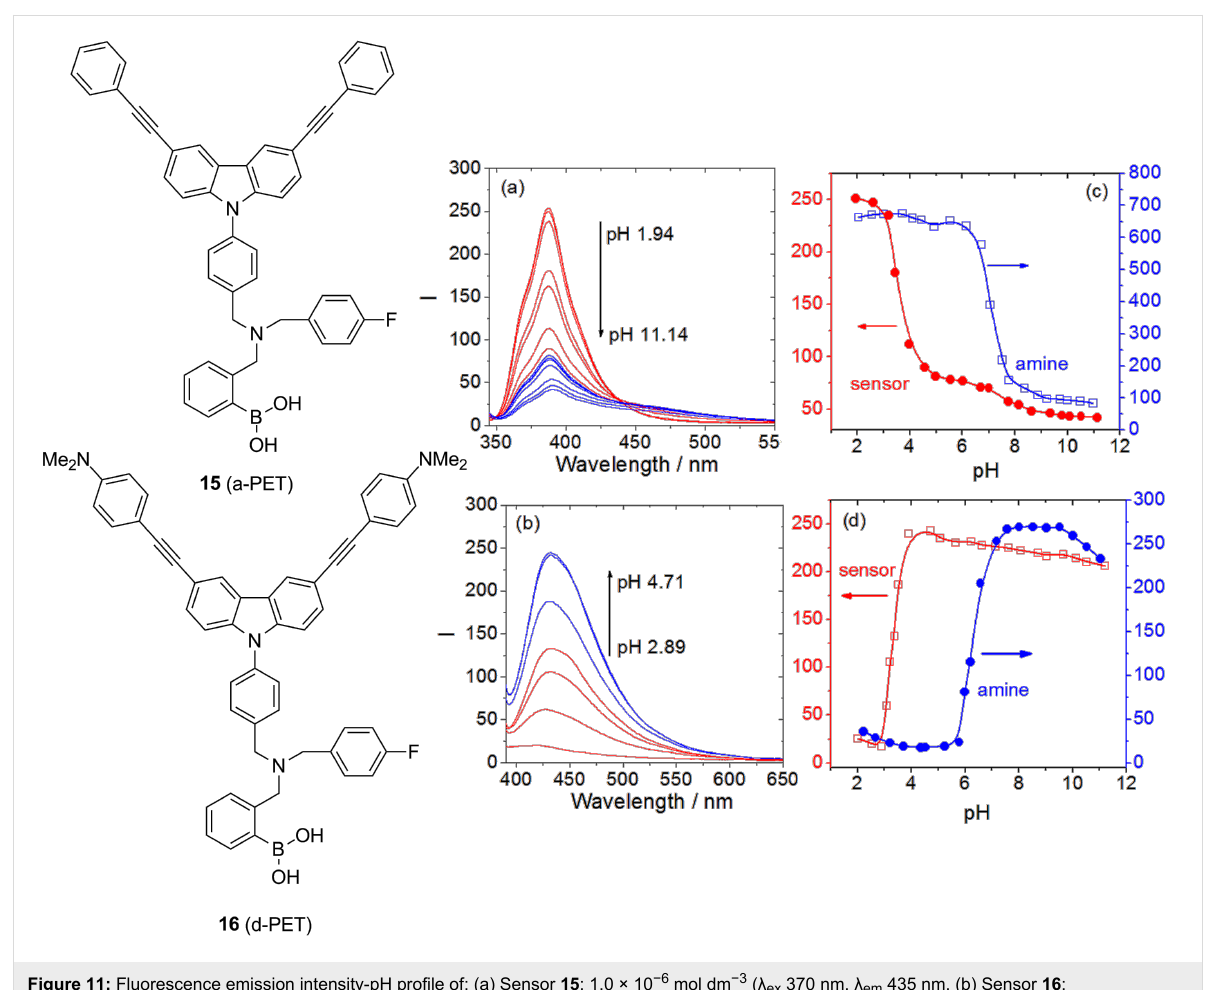
Figure 11: Fluorescence emission intensity-pH profile of: (a) Sensor 15 : 1.0 × 10 − 6 mol dm − 3 ( λ ex 370 nm, λ em 435 nm. (b) Sensor 16 : 1.0 × 10 − 6 mol dm − 3 ( λ ex 335 nm, λ em 390 nm). In 5.0 × 10 − 2 mol dm − 3 NaCl ionic buffer (52.1% methanol in water). Emission spectra of the sensors (c) 15 (1.0 × 10 − 6 mol dm − 3 ), λ ex 370 nm; (d) 16 (1.0 × 10 − 6 mol dm − 3 ), λ ex 335 nm. Sensors in 5.0 × 10 − 2 mol dm − 3 NaCl ionic buffer (52.1% methanol in water, w/w), 25 °C. Reproduced with permission from [64]. Copyright 2010 American Chemical